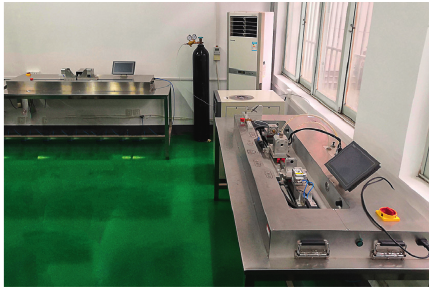
Figure 2: Balloon forming system: DES (left) and BFM